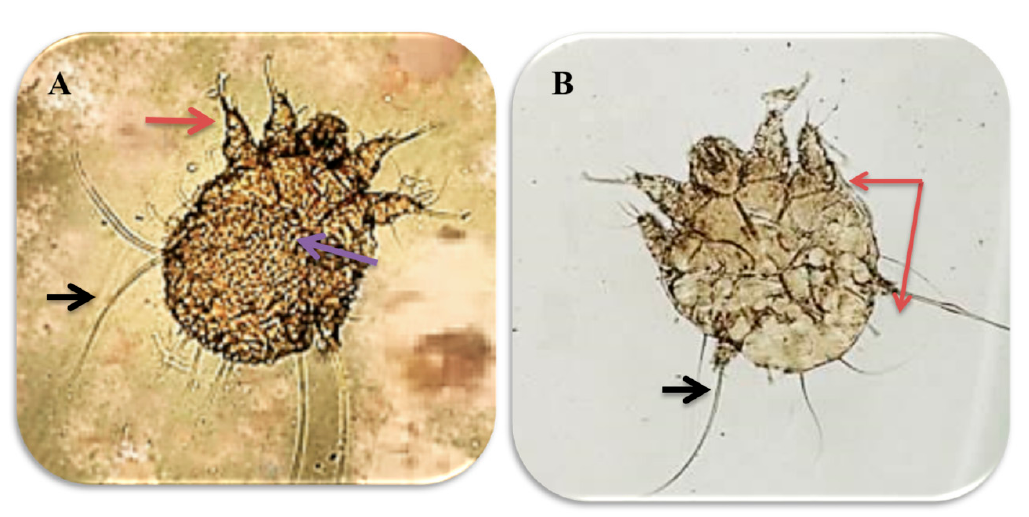
Figure 2. Male and female sarcoptic mange mites under 10× magnification: ( A ) Sarcoptic scabiei female, with transverse ridges and triangular scales on the dorsum (pink arrow). The 1st and 2nd pairs of legs ended with cup-shaped suckers (red arrow) while the 3rd and 4th ones ended with bristles (black arrow); ( B ) Sarcoptic scabiei male, with the 1st, 2nd and 4th pairs of legs ending with cup-shaped suckers (red arrow) and the 3rd pair ended with bristles (black arrow).